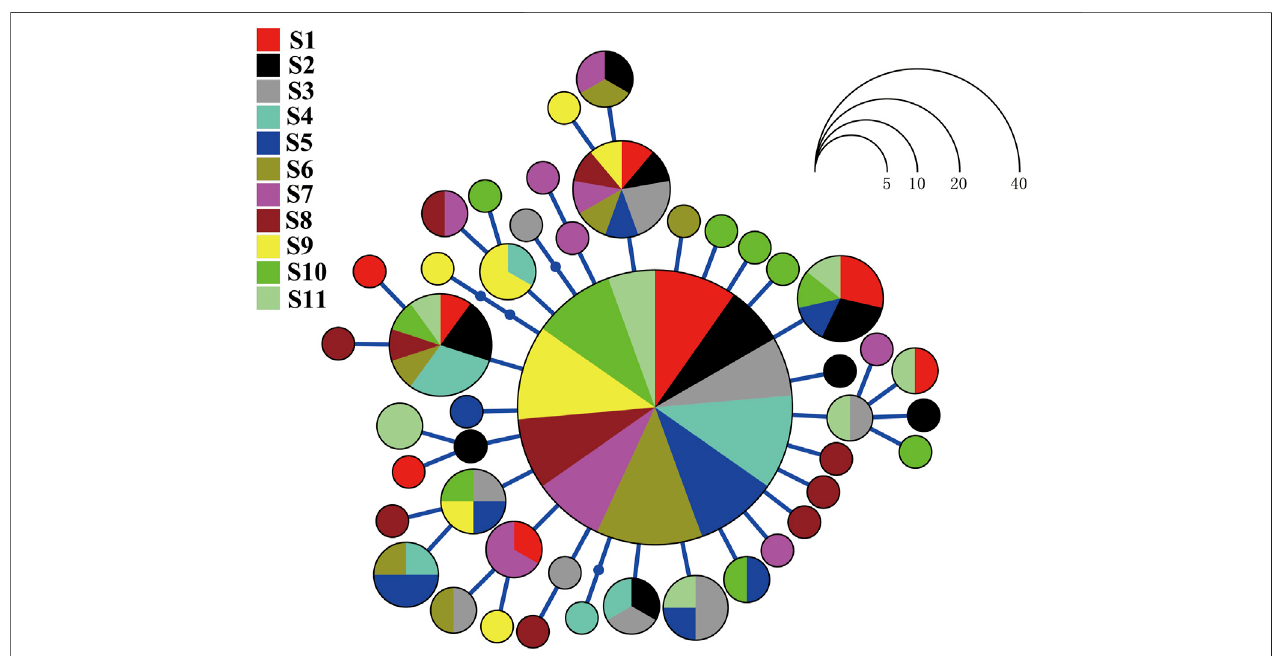
FIGURE 2 | Haplotype network for Evynnis cardinalis on the basis of nucleotide variation at the mitochondrial cytochrome c oxidase subunit I gene. Each circle represents a unique haplotype whose size is proportional to the number of individuals sharing that speci fi c haplotype.